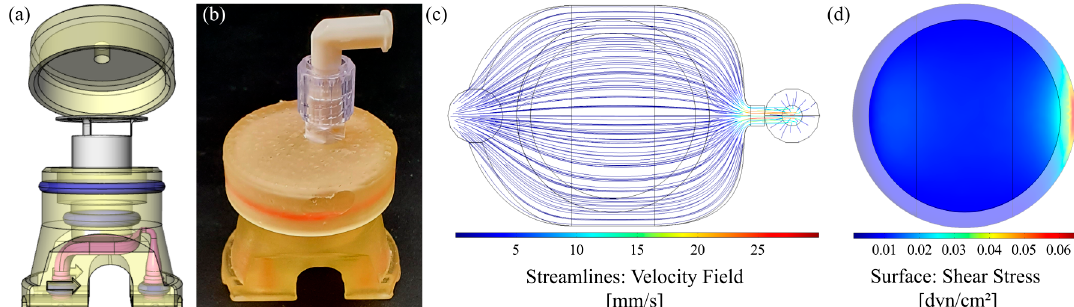
Figure 7. Chamber design for dynamic culture of cells on membranes and evaluation of flow properties. ( a ) CAD model (exploded view) and ( b ) photograph of the assembled 3D-printed culture chamber. ( c ) Corresponding velocity streamline profile within the fluid channel and ( d ) surface shear stress highlighted for the membrane area obtained by CFD simulation at a volume flow rate of 1.42 mL · min − 1